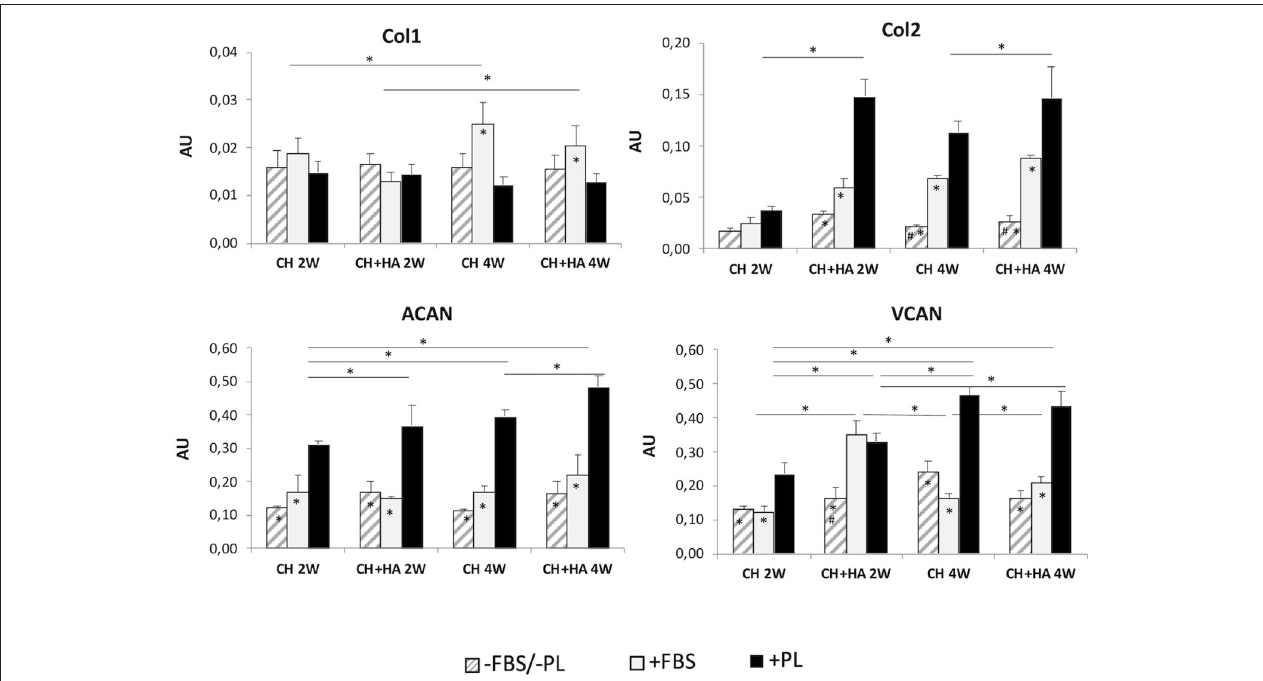
FIGURE 6 | Gene expression of collagen type I , collagen type II , aggrecan , and versican in chondrocytes cultured in chitosan scaffolds (CH) and chitosan scaffolds prepared with hyaluronic acid (CH + HA) after 2 and 4 weeks in different conditions (–FBS/–PL, + FBS, + PL). Statistical analysis: asterisks above the horizontal lines indicate significant differences of condition during time and among materials (* P < 0.05). Within each material, asterisk indicates significant differences vs. PL and hashtag (#) indicates significant differences vs. FBS ( n = 9).